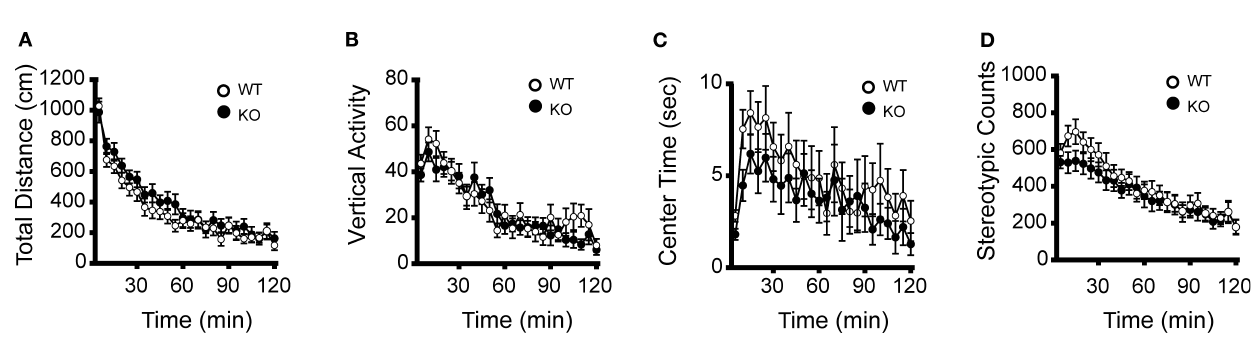
Figure 3 | No signifi cant differences between kf-1 + / + and kf-1 − / − mice in open fi eld test. The kf-1 + / + and kf-1 − / − mice were subjected to the open-fi eld test. = 1.162). (B) Count of vertical activity ( p = 0.7164, F = 0.134). (C) Time spent in the center of the compart- (A) Total locomotion distance ( p = 0.2879, F 1,38 1,38 = 0.747). (D) Count of stereotypic behavior ( p = 0.4435, F = 0.600) (see Section ‘Open fi eld test’). WT and KO stand for kf-1 + / + and ment ( p = 0.3930, F 1,38 1,38 kf-1 − / − mice,